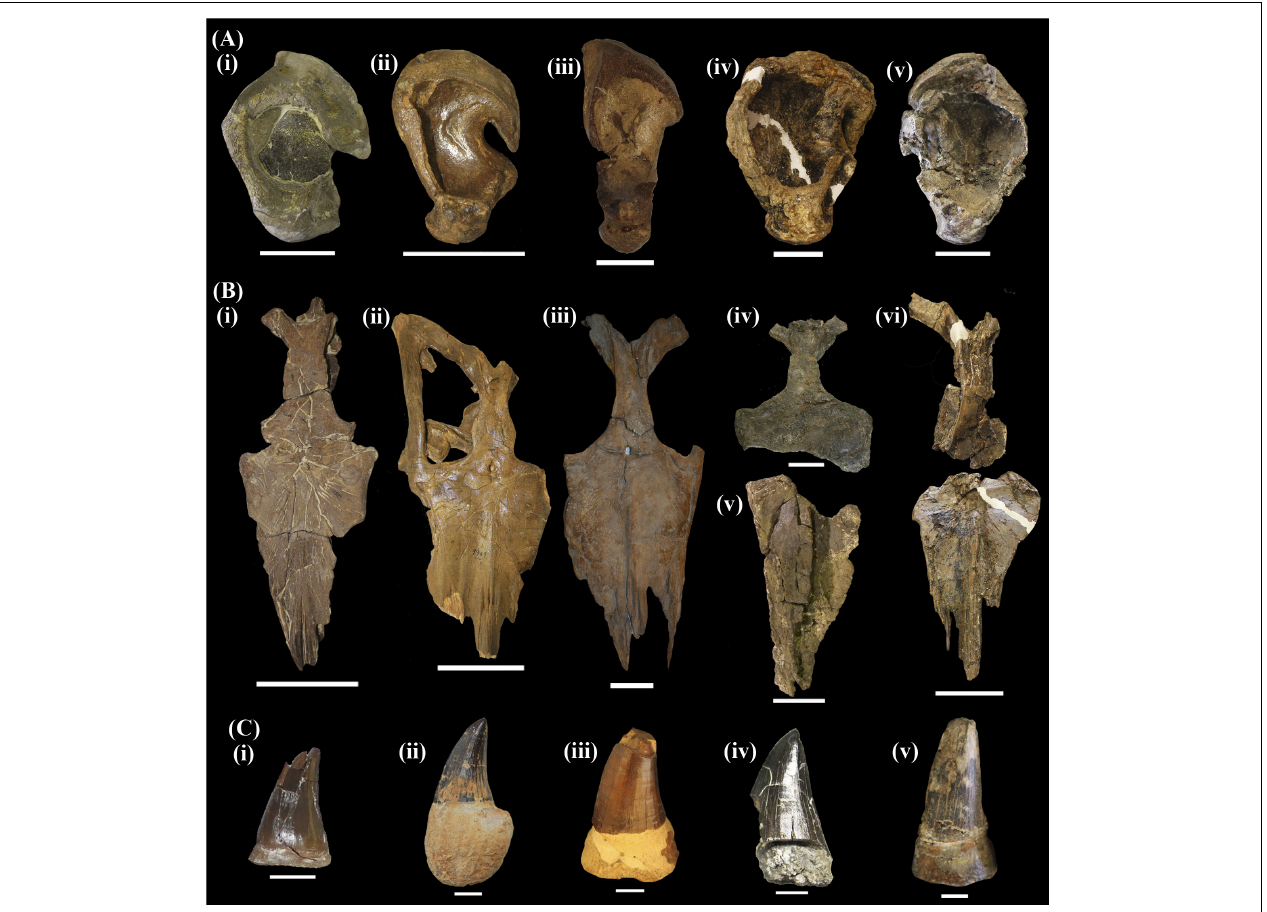
FIGURE 5 | Comparison of cranial elements of different Tylosaurus species: (A) quadrate of: (i) T. nepaeolicus YPM 3970; (ii) T. proriger AMNH 4909; (iii) T. bernardi IRScNB 3672; (iv) T. pembinensis MDM M740506; (v) T. saskatchewanensis RSM P2588.1; (B) frontal and parietal of: (i) T. nepaeolicus YPM 3974; (ii) T. proriger AMNH 4909; (iii) T. bernardi IRScNB R23; (iv) T. pembinensis MMV 95; (v) T. pembinensis MMV 95; (vi) T. saskatchewanensis RSM P2588.1; (C) teeth of: (i) T. nepaeolicus YPM 3969; (ii) T. proriger AMNH 1543; (iii) T. bernardi IRScNB 3672; (iv) T. pembinensis MDM M770507; (v) T. saskatchewanensis RSM P2588.1. Scale bars of (A) equal to 50 mm, scale bars of (B) equal to 100 mm, scale bars of (C) equal to 10